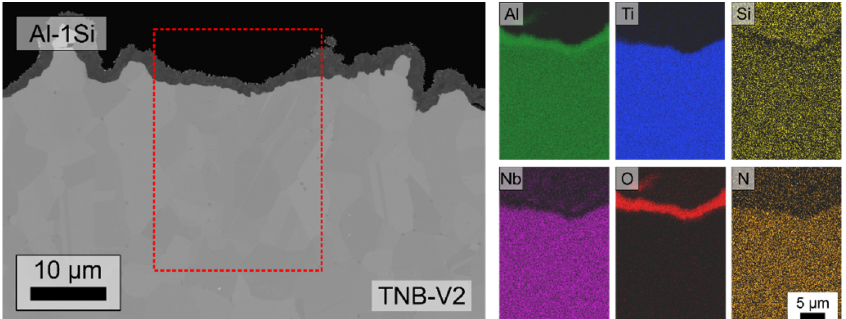
Figure 12. SEM cross sections of the Al-1Si coatings (in at.%) after 5000 cycles of oxidation at 900 °C with elemental mappings of the red marked area.